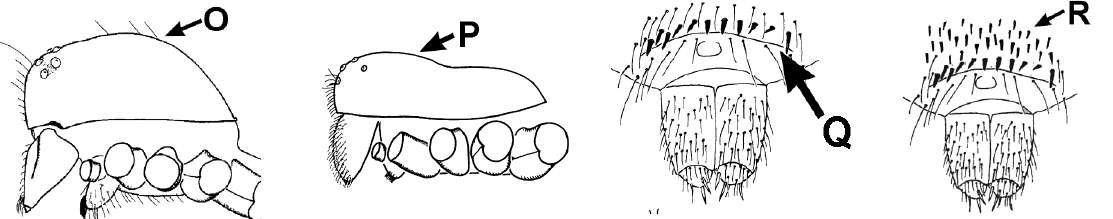
(visible in SEM only) .......................................................................................................................